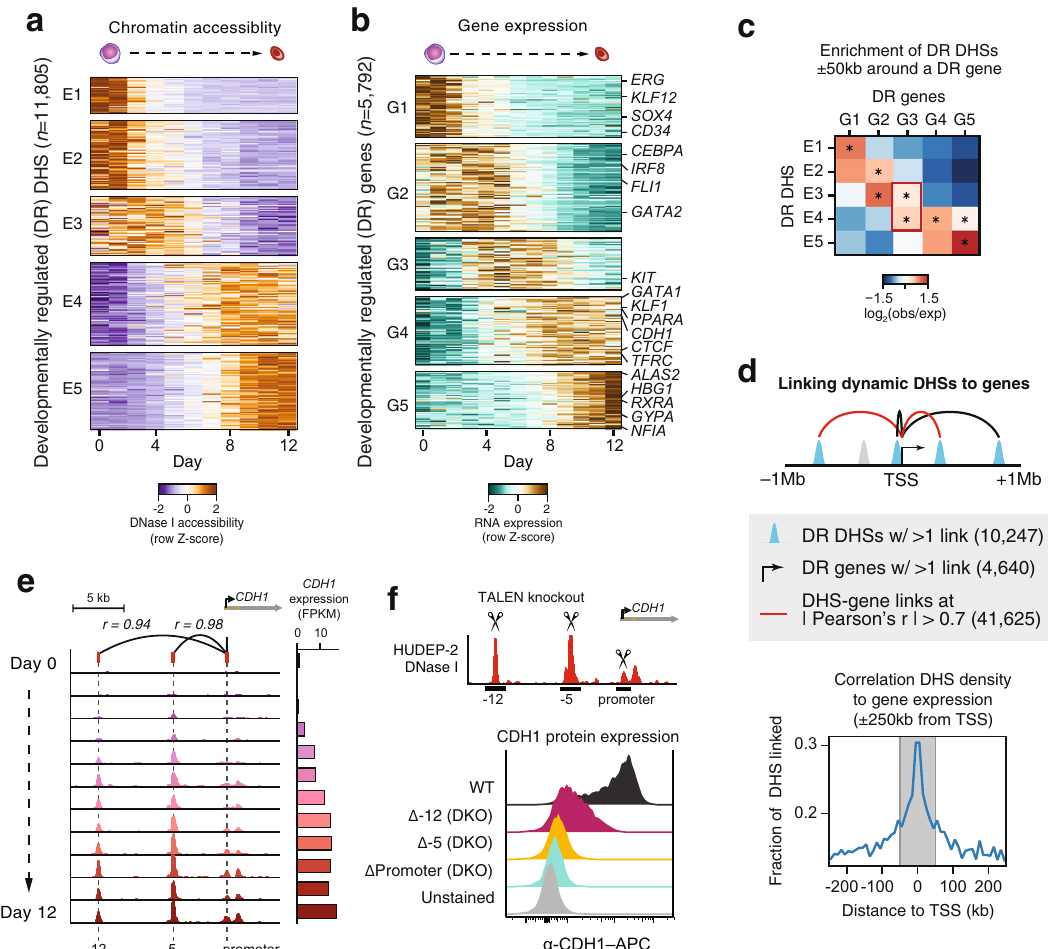
Fig. 2 Temporal compartmentalization of the cis- and trans - regulatory landscape during erythropoiesis. a K -means clustering of 11,805 changing DHS resulted in 5 clusters (E1-E5) with sequential activity pro fi les for each cluster. Values are z -score of per day average normalized DHS counts from 3 donors. b K -means clustering of 5792 developmentally regulated genes resulted in 5 clusters (G1 – G5). Values are z-score of per day average normalized FPKM from 3 donors. c A matrix showing the enrichment score (log2-ratio observed over expected) for any given DHS cluster, around each developmentally regulated DHS ( ± 50 kb from TSS). Highlighted in red is cluster G3 which is enriched for both late downregulated DHS of cluster E3 and early upregulated from cluster E4. Asterisks denote X 2 test p -value < 0.05. d Correlation density plot between developmental genes and developmental DHS ± 250kb around the gene promoter. Gray shaded area highlights enrichment of correlations within ±50kb around the gene promoter. e DNase I accessibility track of the CDH1 locus during erythroid differentiation, highlighting the accessibility of 3 nearby DHS correlated to CDH1 expression. f DNase I accessibility track of the CDH1 locus in HUDEP-2 cells depicting the genetic knockout of the CDH1 promoter and two upstream DHS (-12, and -5) (above) along with the resulted ablation in CDH1 protein expression as assessed by fl ow cytometry